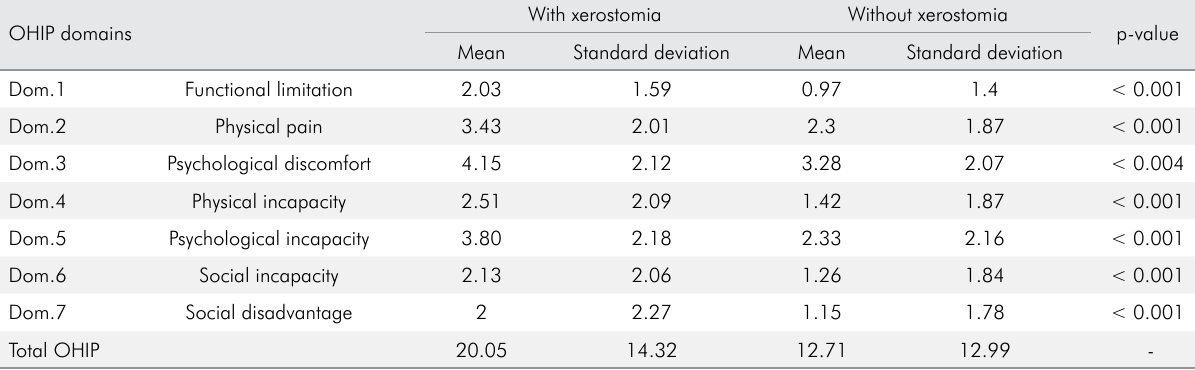
Table 4. Comparison of the OHIP-14sp scores for xerostomia vs. non-xerostomia